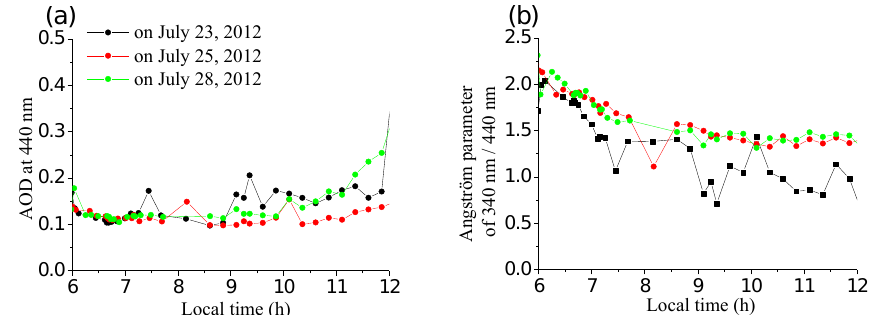
Figure 3. Time series of the AOD at 440nm (a) and the Ångström parameter of 340nm against 440nm (b) from AERONET on 23, 25 and 28 July, 2012.